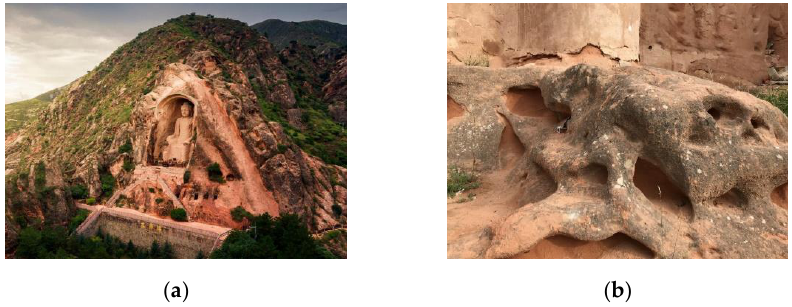
Figure 14. ( a ) Buddha statue in Cave 5; ( b ) wind erosion symptoms of Buddha foot.